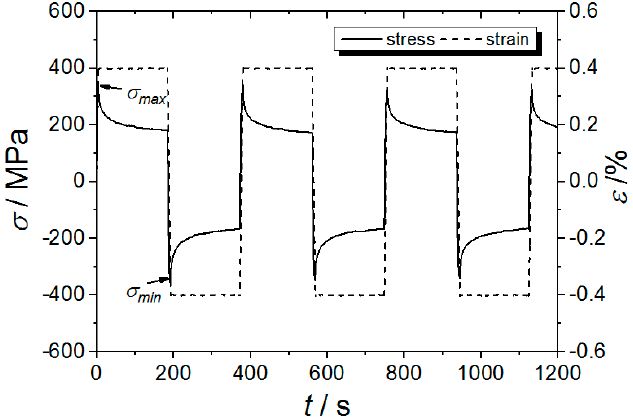
Figure 10. Stress and strain evolutions during the initial cycles of a tension–compression relaxation fatigue (RF) test with strain-controlled holds ( t h = 3